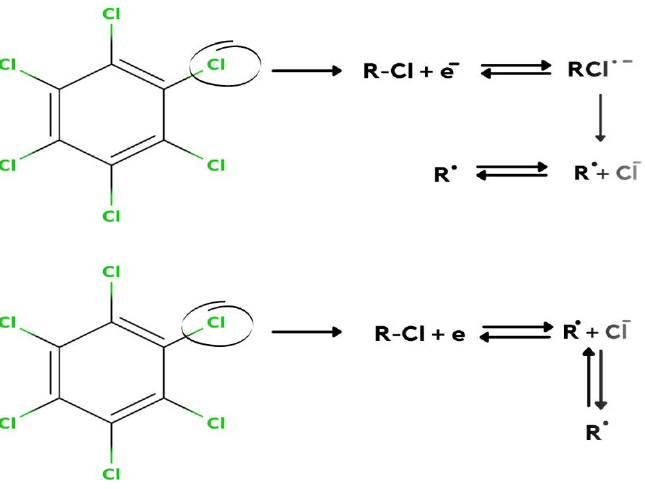
Figure 4. SWV of GCE–AONP–PANI–SWCNT electrode in 0.0–18.8 nM in lindane. Reprinted with permission from Hindawi Publishing Corporation , 2018 [27].